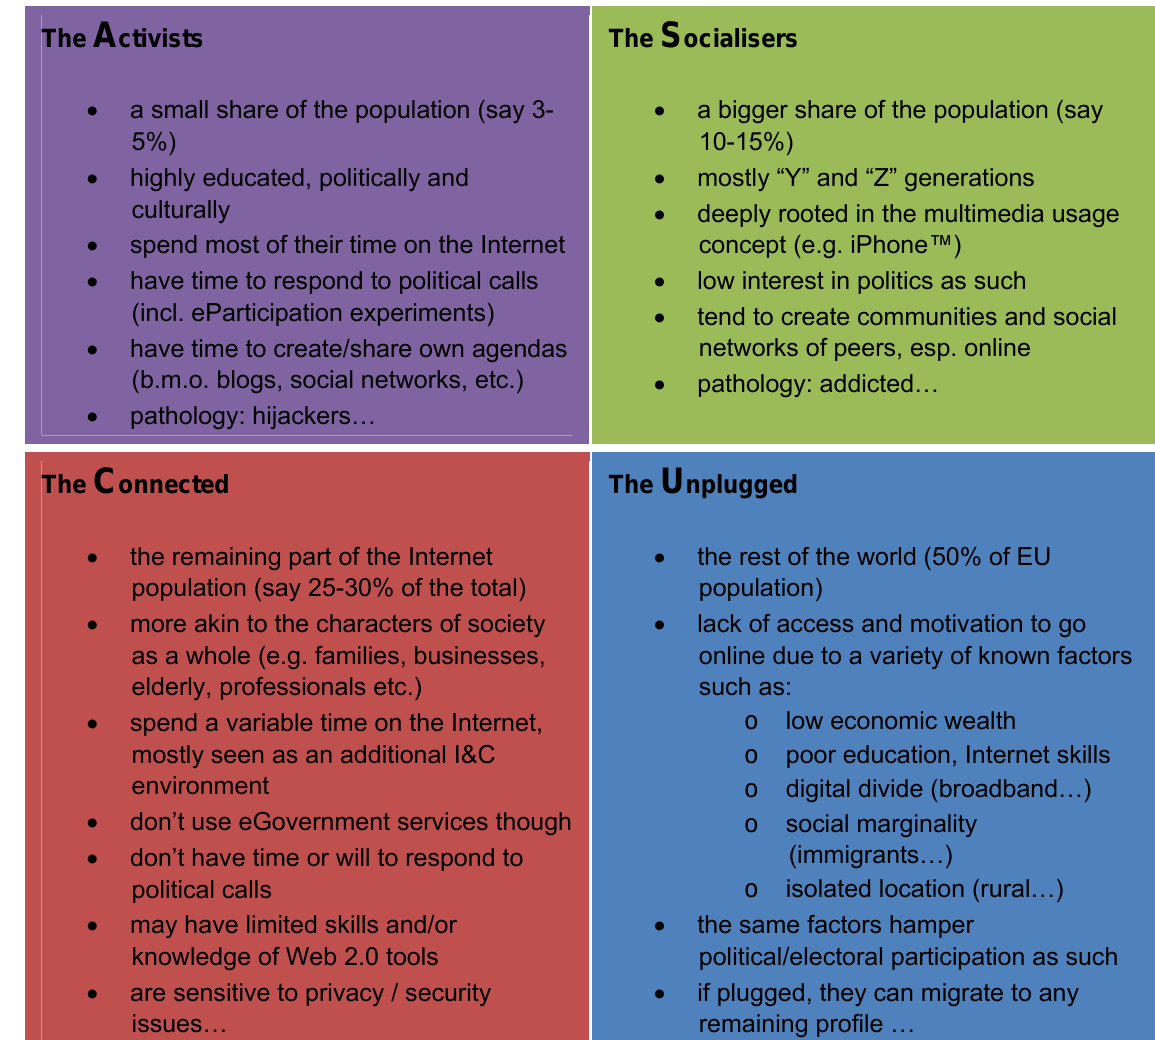
Table 2: The ASCU model The A